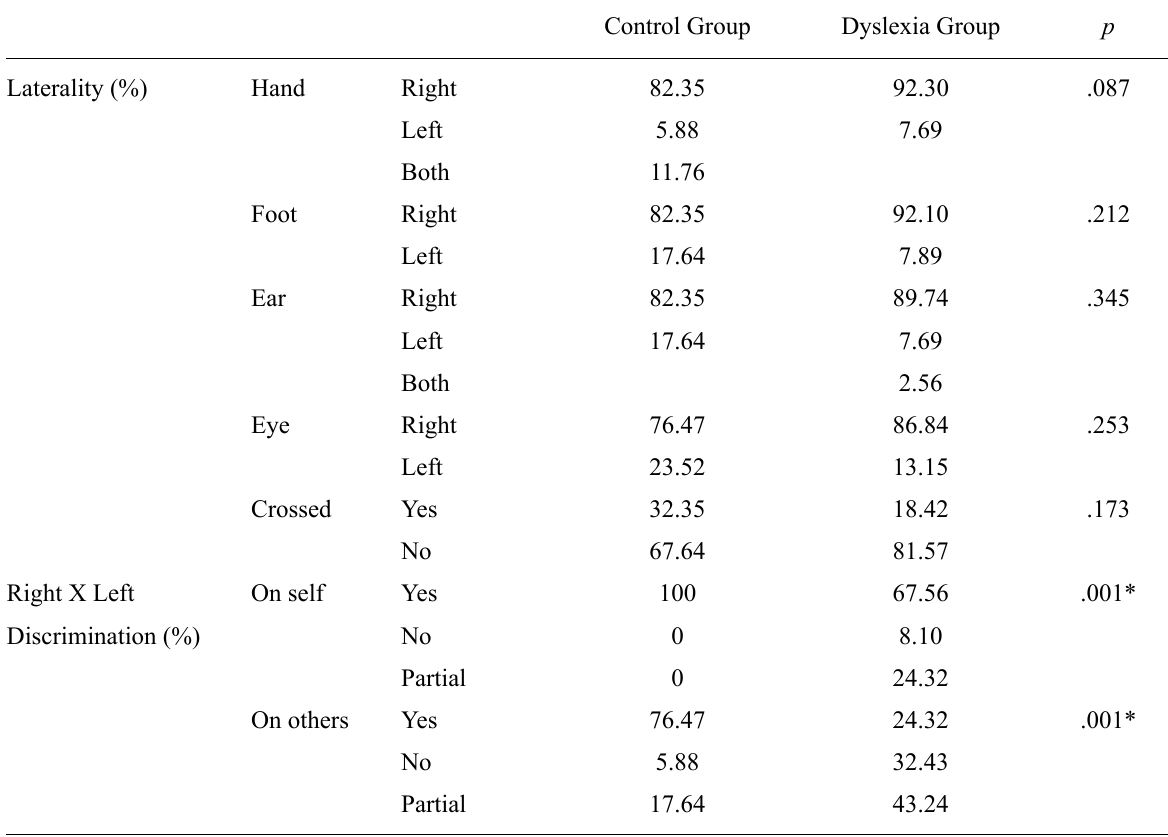
Table 2 Performance of Control Group and Dyslexia Group in Laterality and Right-Left Discrimination (General Linear Models)